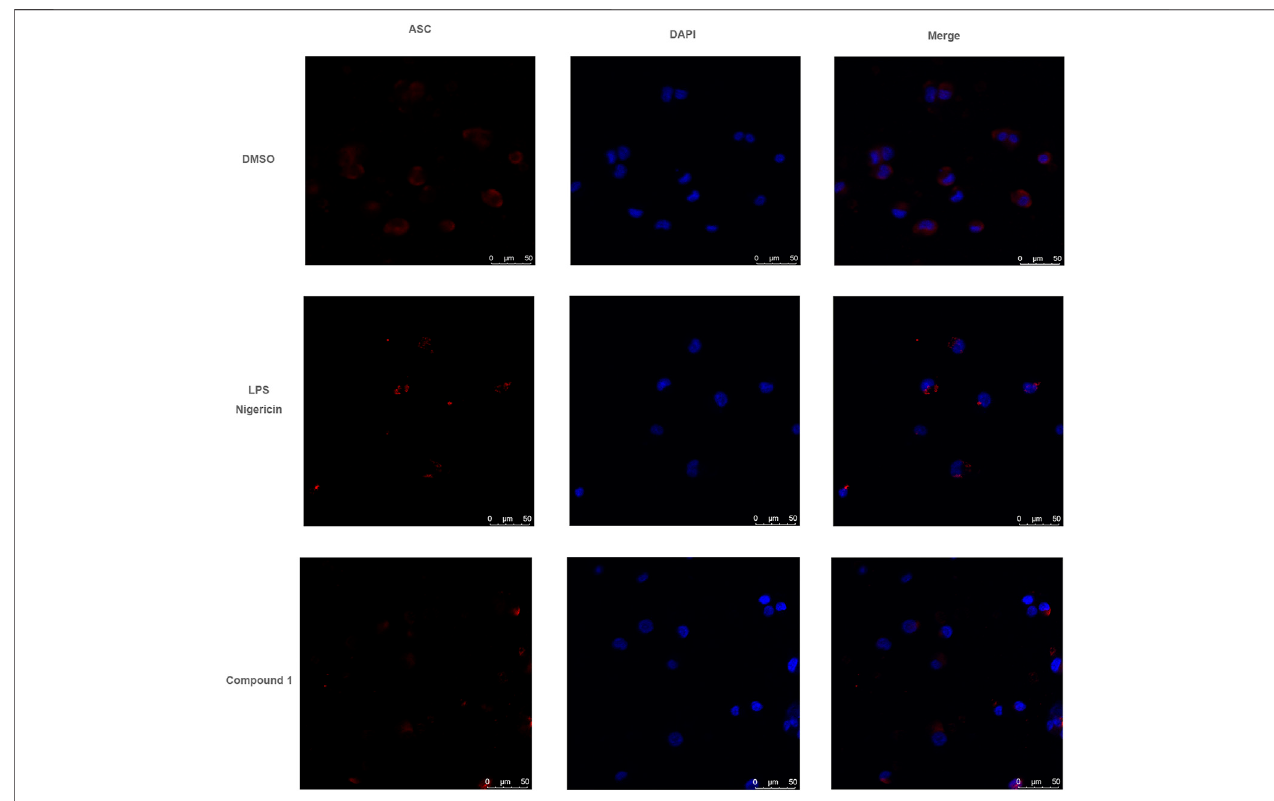
FIGURE 5| Compound1 restrained ASC oligomerization. LPS (1 μ g/ml) priming PMA-differentiated THP-1 cells were treated with compound 1 (10 μ M) or DMSO and stimulated with nigericin, confocal immuno fl uorescent images of ASC, DAPI are displayed.